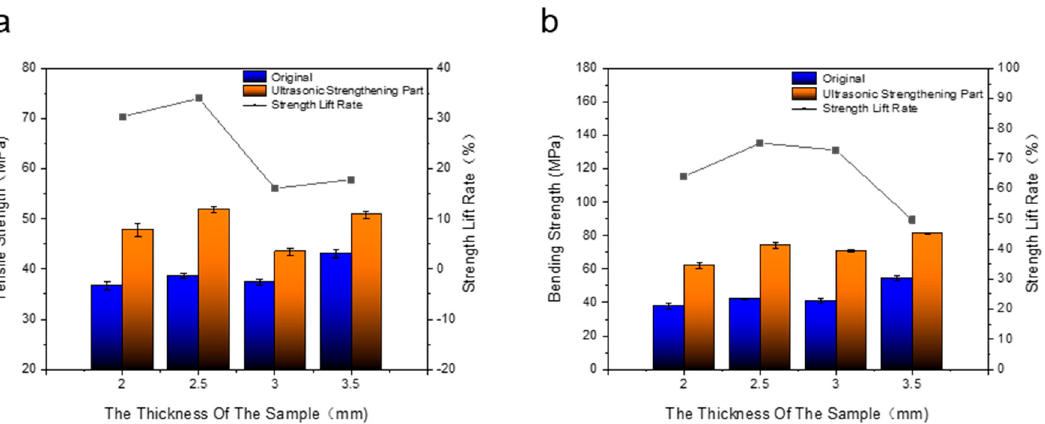
Figure 12. ( a ) Tensile strength of samples with different thicknesses before and after ultrasonic strengthening. ( b ) Bending strength of samples with different thicknesses before and after ultrasonic strengthening.